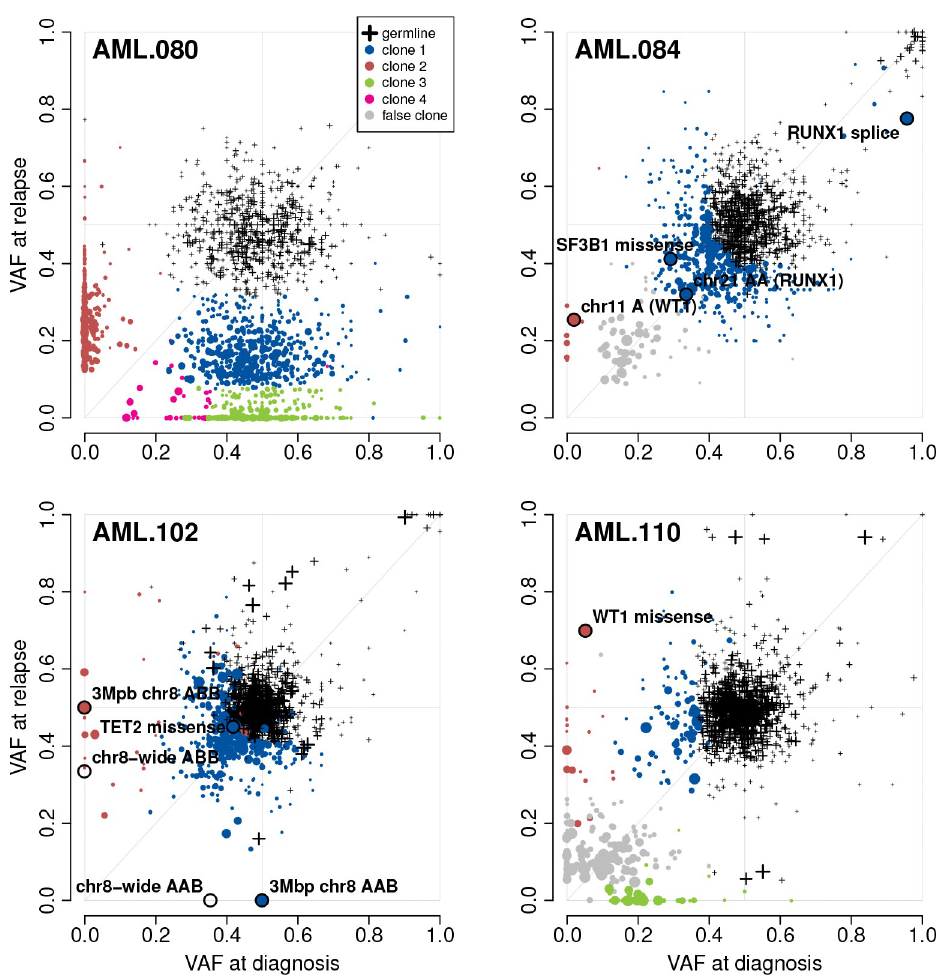
Fig 6. Assessment of clonal structure in AML using SuperFreq without matched normal controls. Clone scatter plots of four AML patients (as in Fig 5), generated without using the matched normal sample. We include the germline clone to illustrate how it absorbs germline variants, as well as some somatic variants that have high clonality in both samples. While this is done successfully in AML.080 and AML.110, the two other samples have a large number of variants designated as somatic that are not identified in the cancer-normal analysis. AML.084 and AML.110 identify clones at low clonality in both samples that are not seen in the cancer-normal analysis, shown in